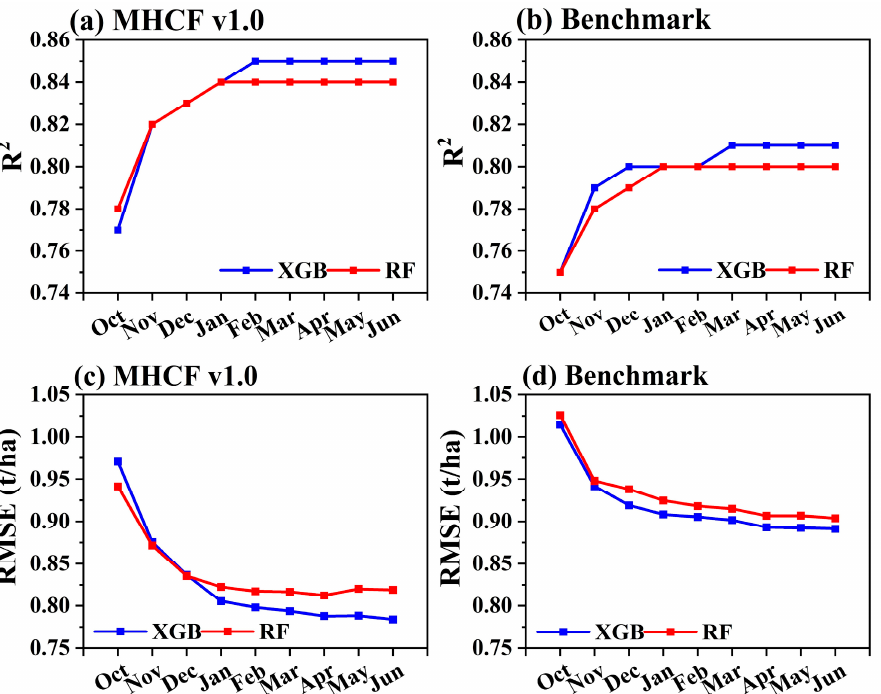
Figure 10. Temporal progression of model performance (R 2 and RMSE) based on the four models: ( a , c ) models trained with S2S atmospheric predictions; ( b , d ) models trained with observational climate variables.